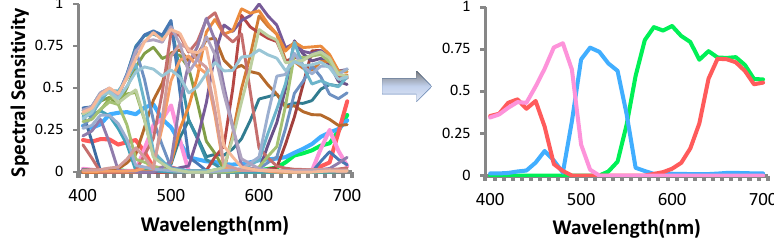
Figure 7. Four channels selected from a candidate